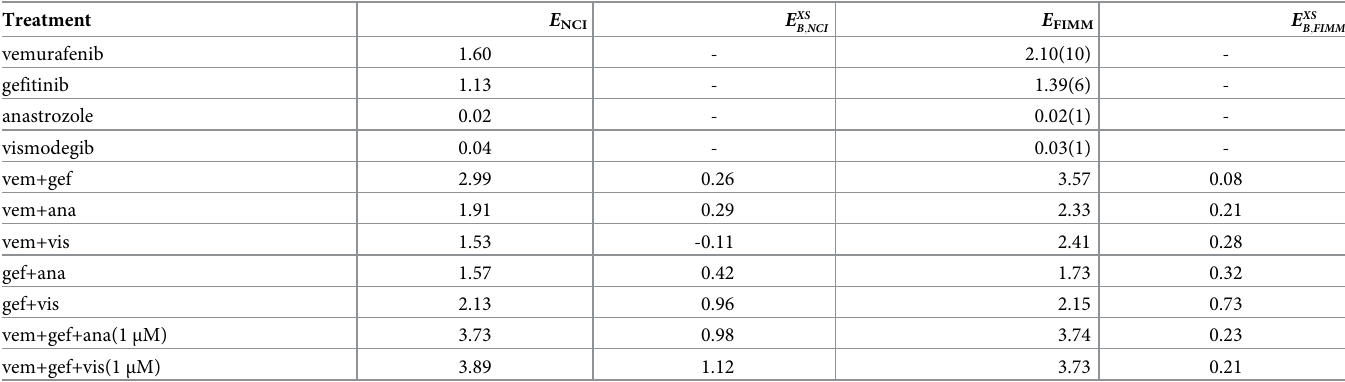
Table 2. NCI ALMANAC and FIMM drug assays on MALME-3M.